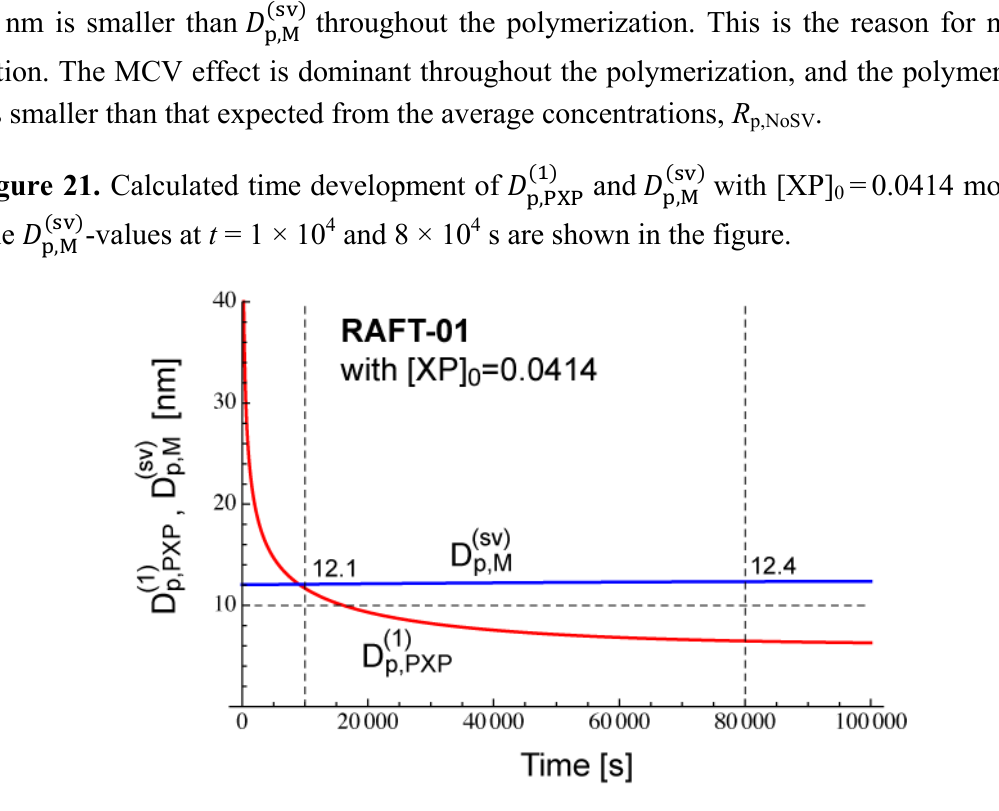
Figure 22. Conversion development for miniemulsion RAFT-01 polymerization with = 10 nm, obtained from MC simulation ( blue ), from R given by Equation (12) D p p,NoSV given by Equation (20) ( red ), and from the exact rate expression ( orange ), from R p,MCV accounting for the statistical variation of all three components given by Equation (11) = 0.0414 mol L − 1 ( black ), as well as for the bulk polymerization with [XP] 0